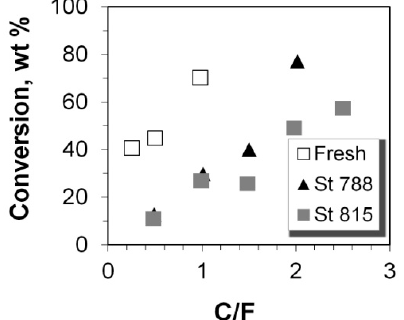
Figure 4. Conversion (wt%) of n-C 12 versus catalyst-to-feed (C/F) ratio for the fresh and steamed P/ZSM-5 additives.